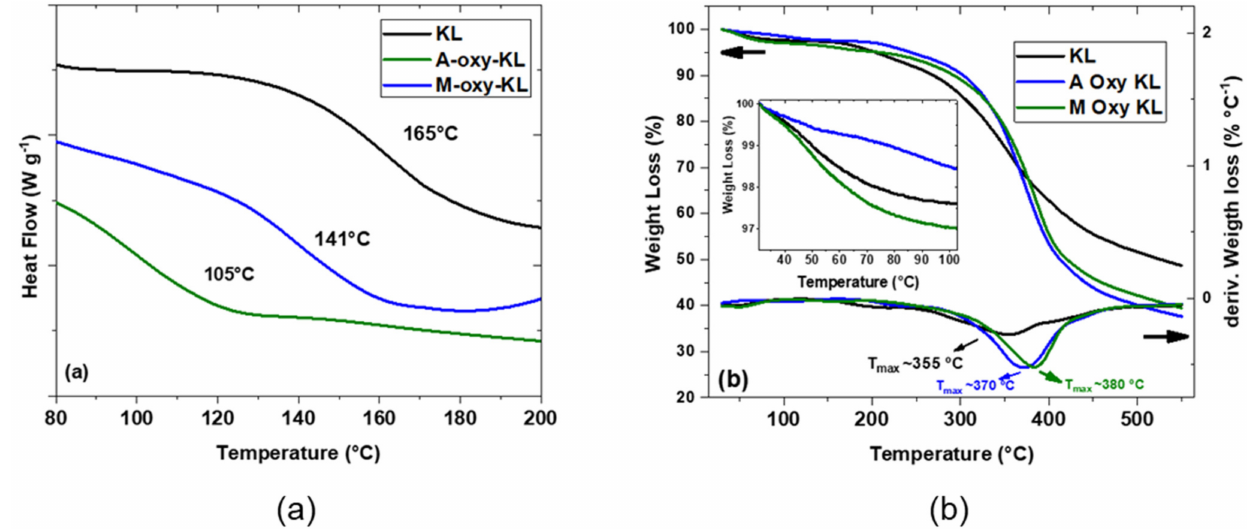
Figure 3. ( a ) Heat flow evolution with temperature of pristine lignin (KL) and its derivatives (A-oxy- KL and M-oxy-KL) ( b ) Weight loss (%) (left axis) and derivative of weight loss (right axis) curves of pristine lignin (KL) and its derivatives (A-oxy-KL and M-oxy-KL). Insert: zoom on the 40 to 100 ◦ C range to highlight the differences in moisture loss.